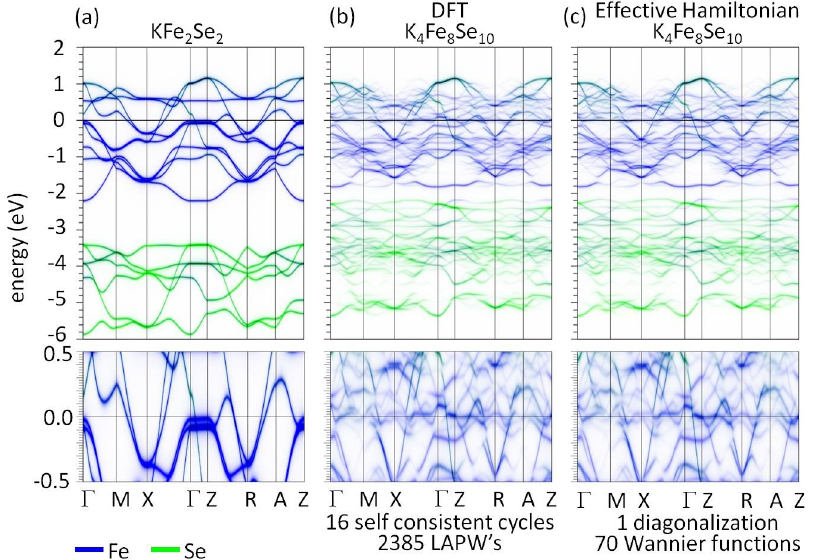
Figure 29. Spectral functions of the clean reference system KFe 2 Se 2 ( a ) and K 4 Fe 8 Se 10 with one K vacancy and two Fe vacancies obtained from DFT ( b ) and the effective Hamiltonian method ( c ). Reprint from